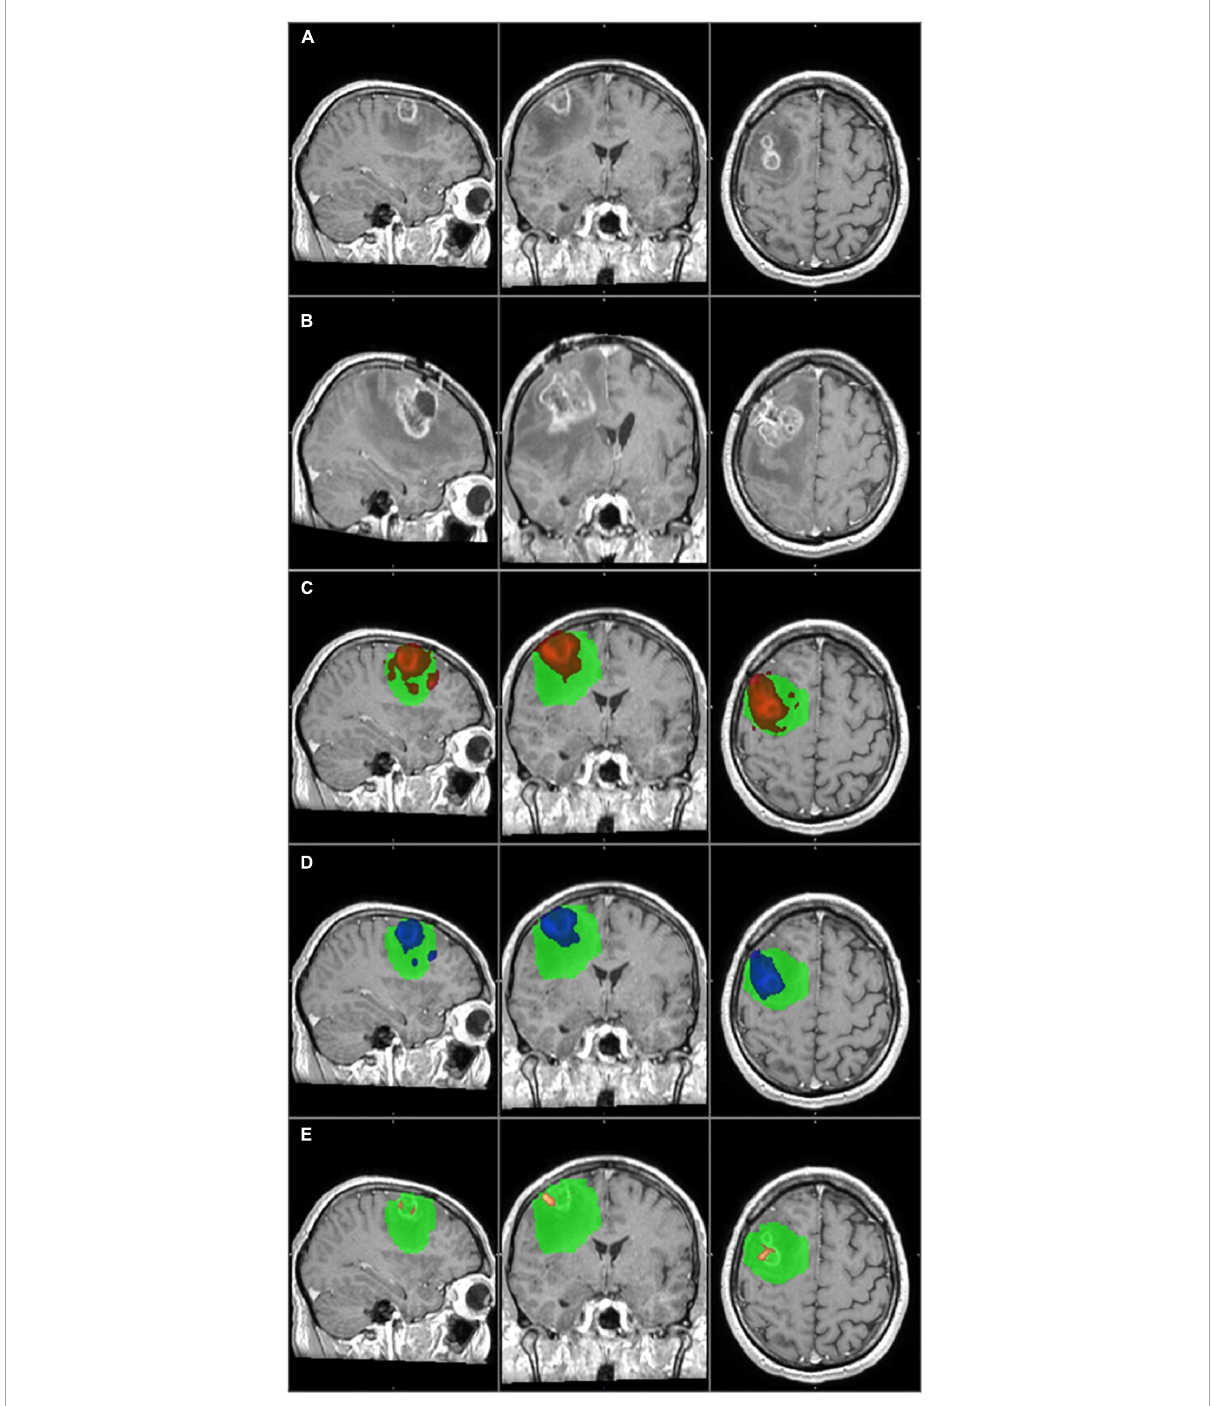
FIGURE4 The primary tumor, the recurrence tumor, and the overlap between the different TCs and the tumor recurrence mask of the representative case of Patient 20 are displayed in this figure. All images are transformed to the MNI152 1 mm space. (A) The preoperative contrast enhanced T1 image. Two small tumors with ring shaped contrast enhancement can be seen in the right frontal region. (B) The size and the location of the tumor recurrence. (C) The 1% TC (red) is overlapped on the tumor recurrence mask (green). (D) The 5% TC (blue) is overlapped on the tumor recurrence mask (green). (E) The 40% TC (red-yellow) is overlapped on the tumor recurrence mask (green). (C–E) Are on the preoperative T1 images. As it can be seen, the TCs are fully overlapping with the tumor recurrence mask and therefore the specificity is 100% at every threshold. On the other hand the recurrence remarkably exceeds the border of the TCs, and the sensitivity is low, even at 1%. Please note that the direction of the recurrence is in correspondence with the TCs, and the low sensitivity is the result of the fast tumor